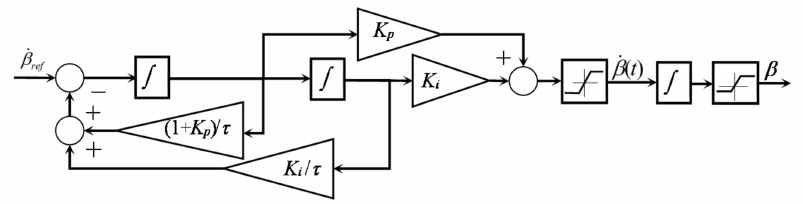
Figure 20. First order pitch actuator with PI control and pitch rate set point.